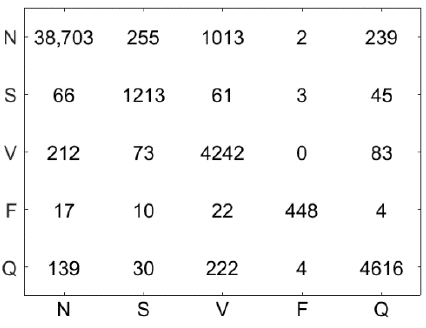
Figure 16. Confusion matrix using the LEDL model.